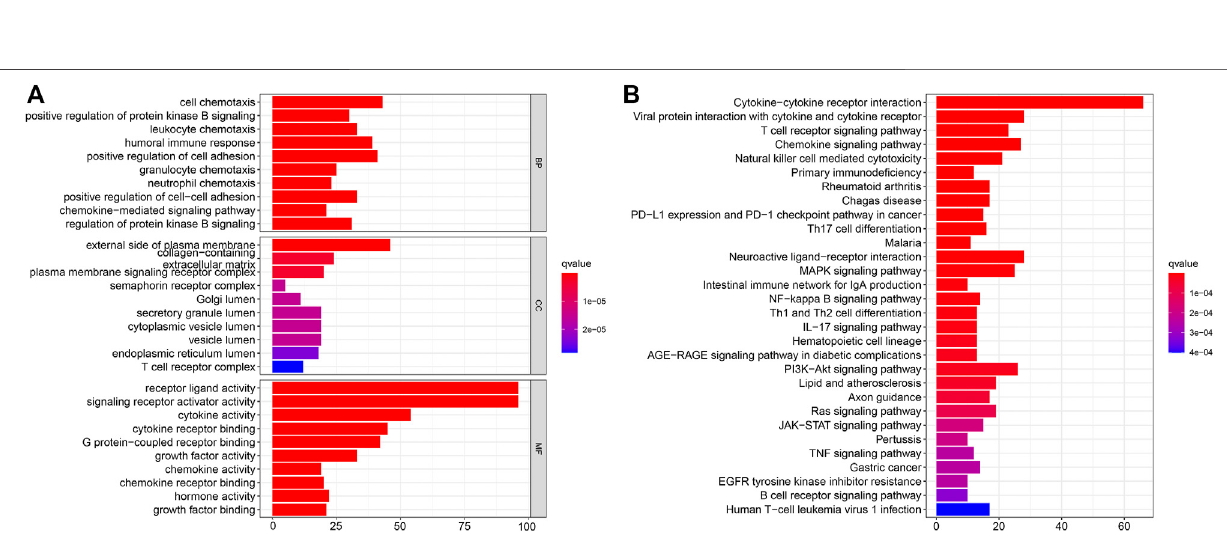
Frontiers in Genetics |